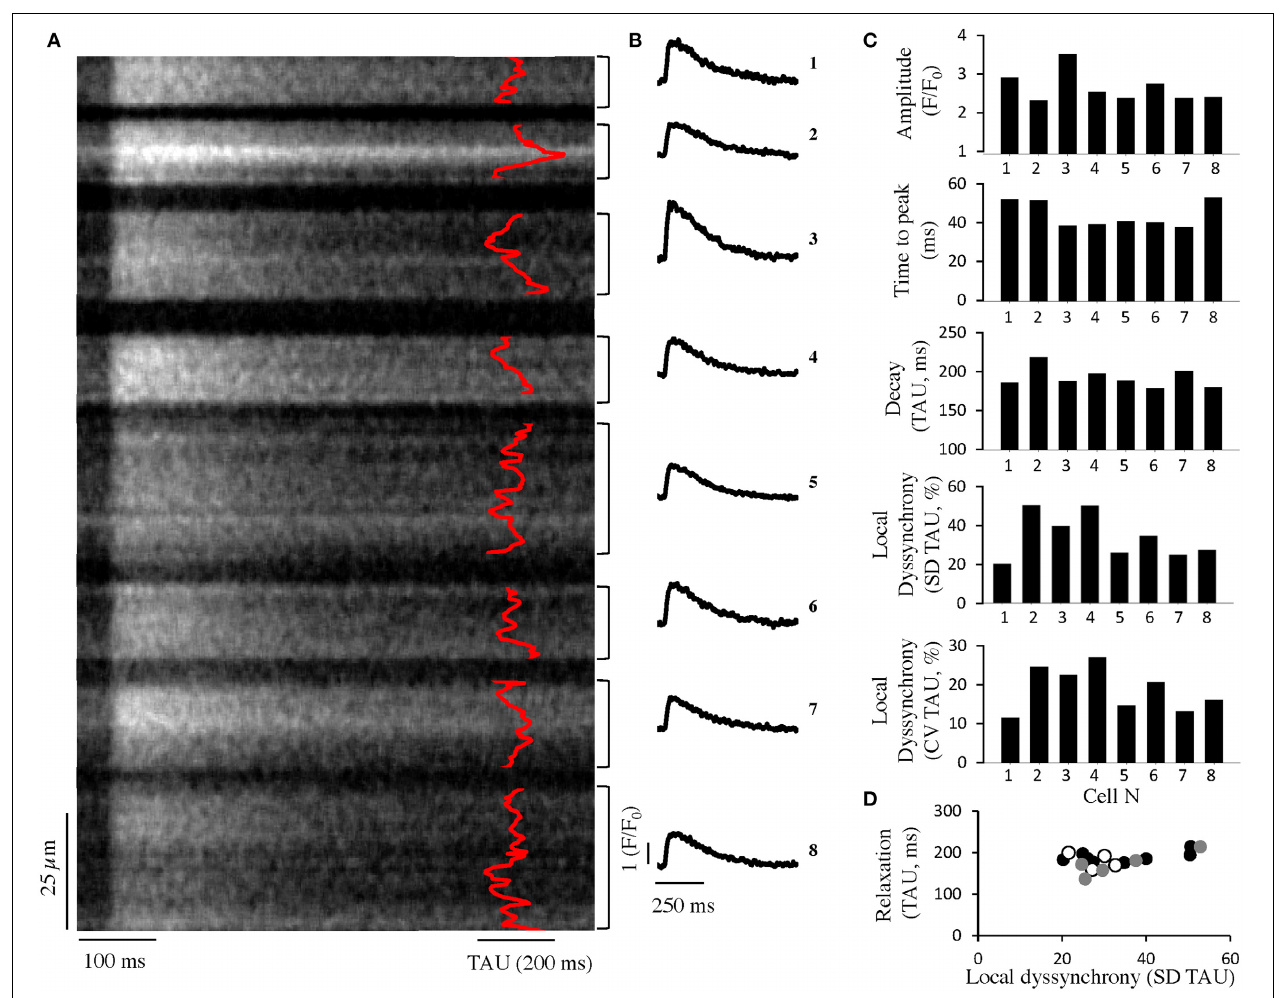
FIGURE 1 | Intracellular dyssynchrony of cytosolic Ca removal in intact hearts. (A) Averaged confocal line-scan image of seven consecutive CaT during spontaneous activation ( ∼ 1.4Hz) from mouse ventricle in eight adjacent cells. The time constant of local Ca decay is superimposed in red. (B) Global Ca transients of the cells shown in (A) . (C) Quantification of the CaT amplitude ( top ), time to peak ( center, top ), relaxation ( center, bottom )